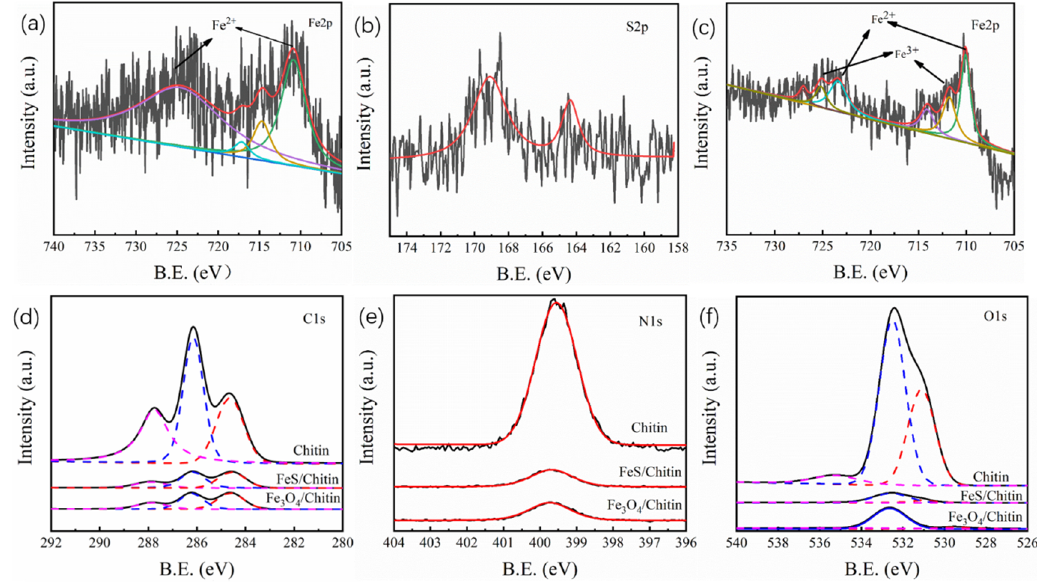
Figure 5. Photoelectron spectra of chitin and Fe/chitin ( a ) Fe 2p; ( b ) S 2p; ( c ) Fe 2p; ( d ) C1s; ( e ) N1s; ( f ) O1s.